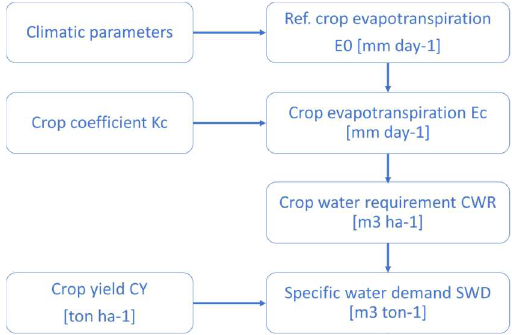
Figure 6. Steps in calculation of virtual water trade.